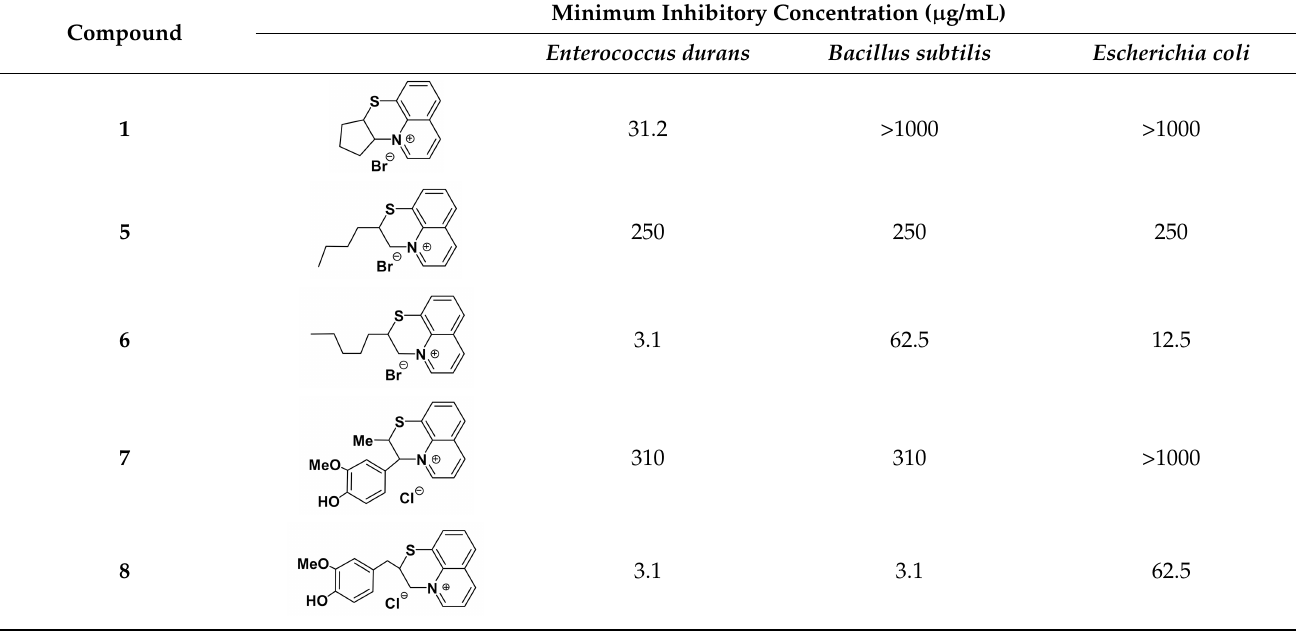
Table 1. The evaluation of antibacterial activity of compounds 1 , 5 – 14